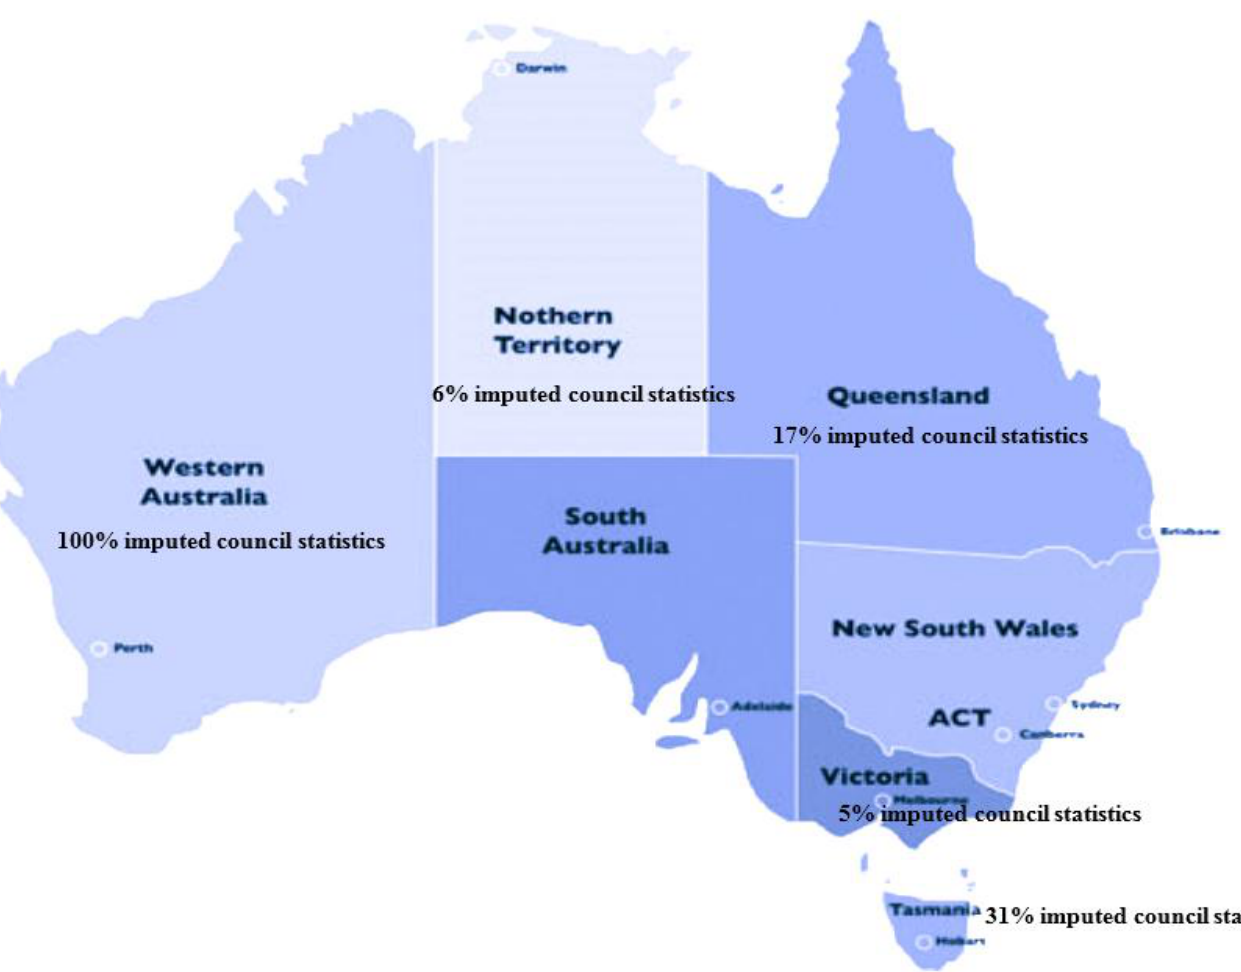
Figure A2. Map of Australia with imputed council statistics (proportions of the estimated numbers of admissions for the state or territory that were imputed municipal council admissions) in each state. No municipal council data were imputed for New South Wales, Australian Capital Territory or South Australia.